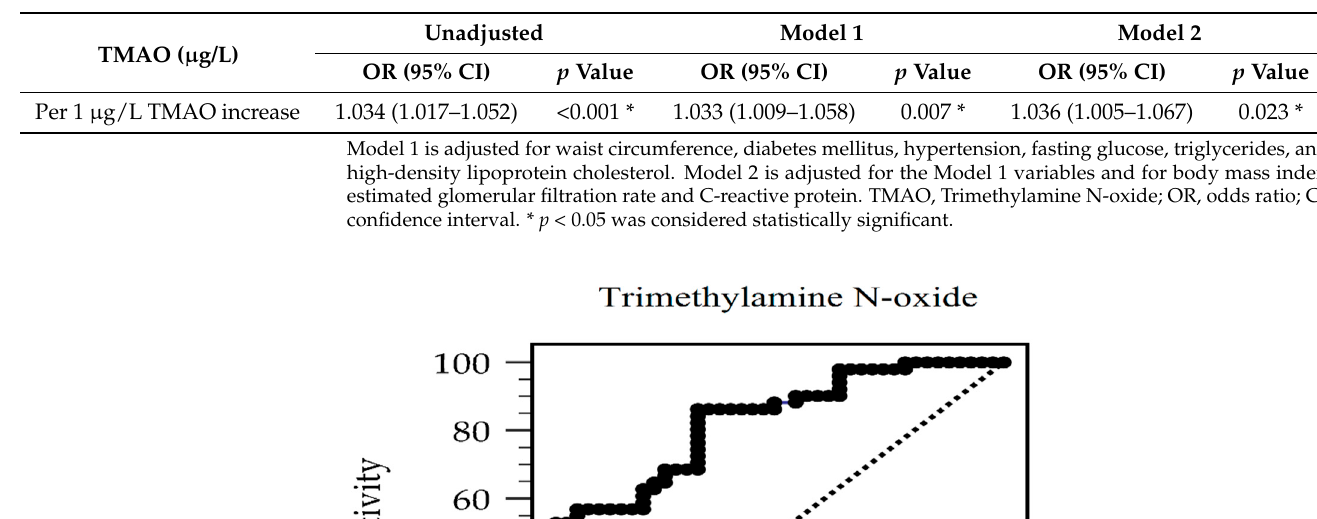
Table 2. Multivariable logistic regression investigation of serum trimethylamine N-oxide levels among 92 coronary artery disease patients.